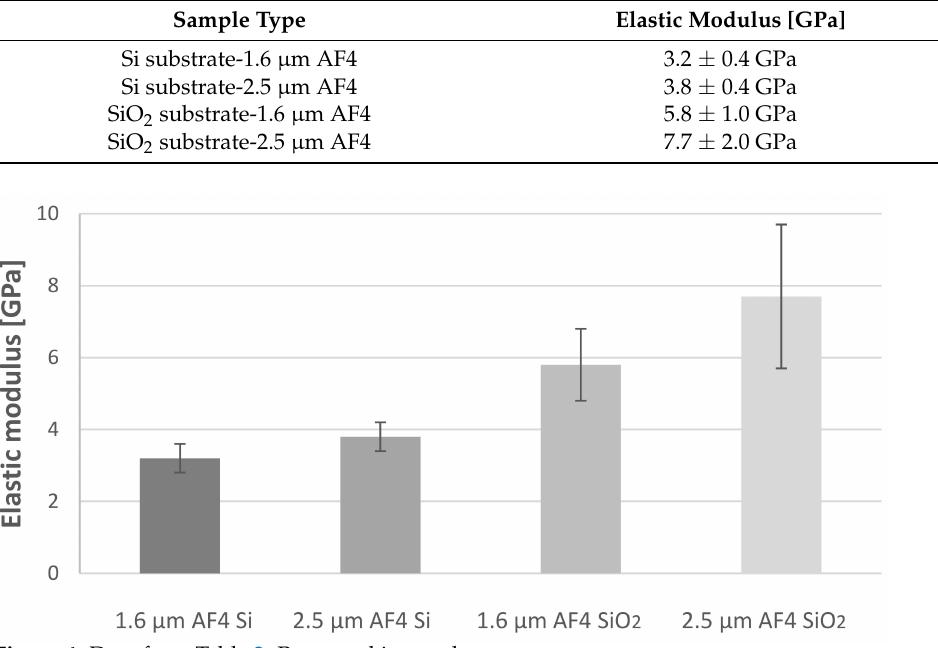
Figure 4. Data from Table 2. Presented in